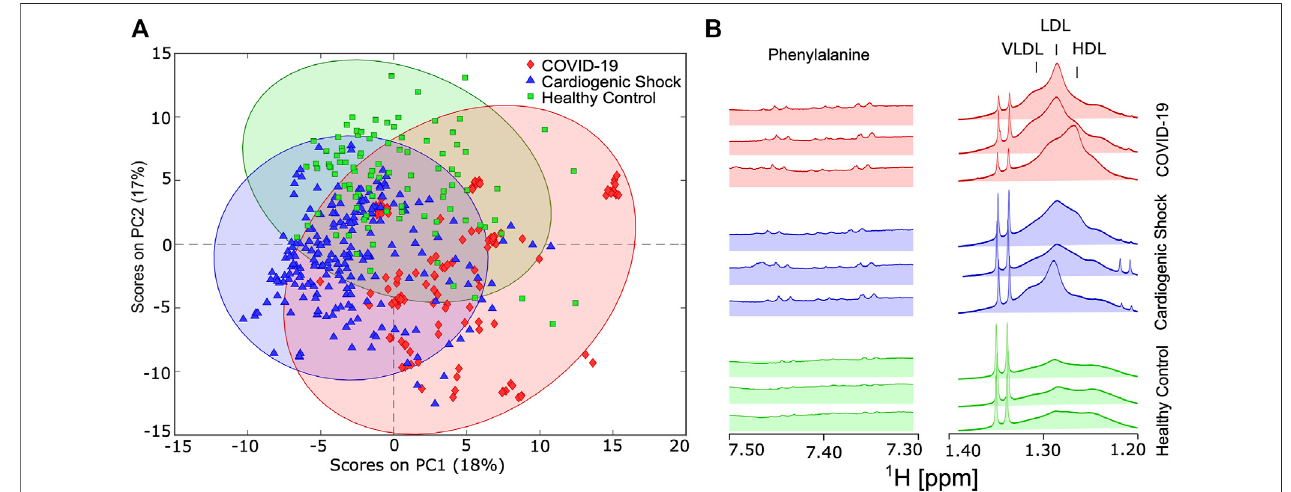
FIGURE 2 | (A) Score plot of principal component analysis using variance-scaled and mean-centered IVDr NMR data for longitudinally collected serum samples fromCOVID-19patients(red)andcardiogenicshock(CS)patients(blue), aswellasone-time samplesfromhealthycontrols(HC)(green). (B) Keysectionsof1D-NOESY spectra showing typical differences between HC, CS, and COVID-19